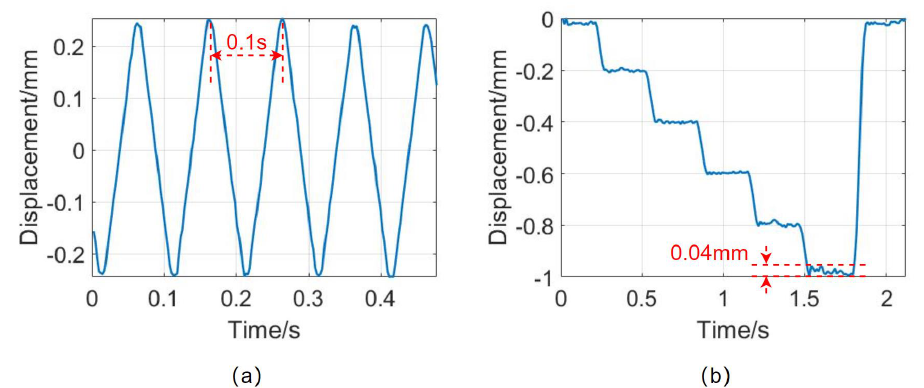
Figure 11. ( a ) The measured shift of the reciprocating motion. ( b ) The measured shift of the step motion.